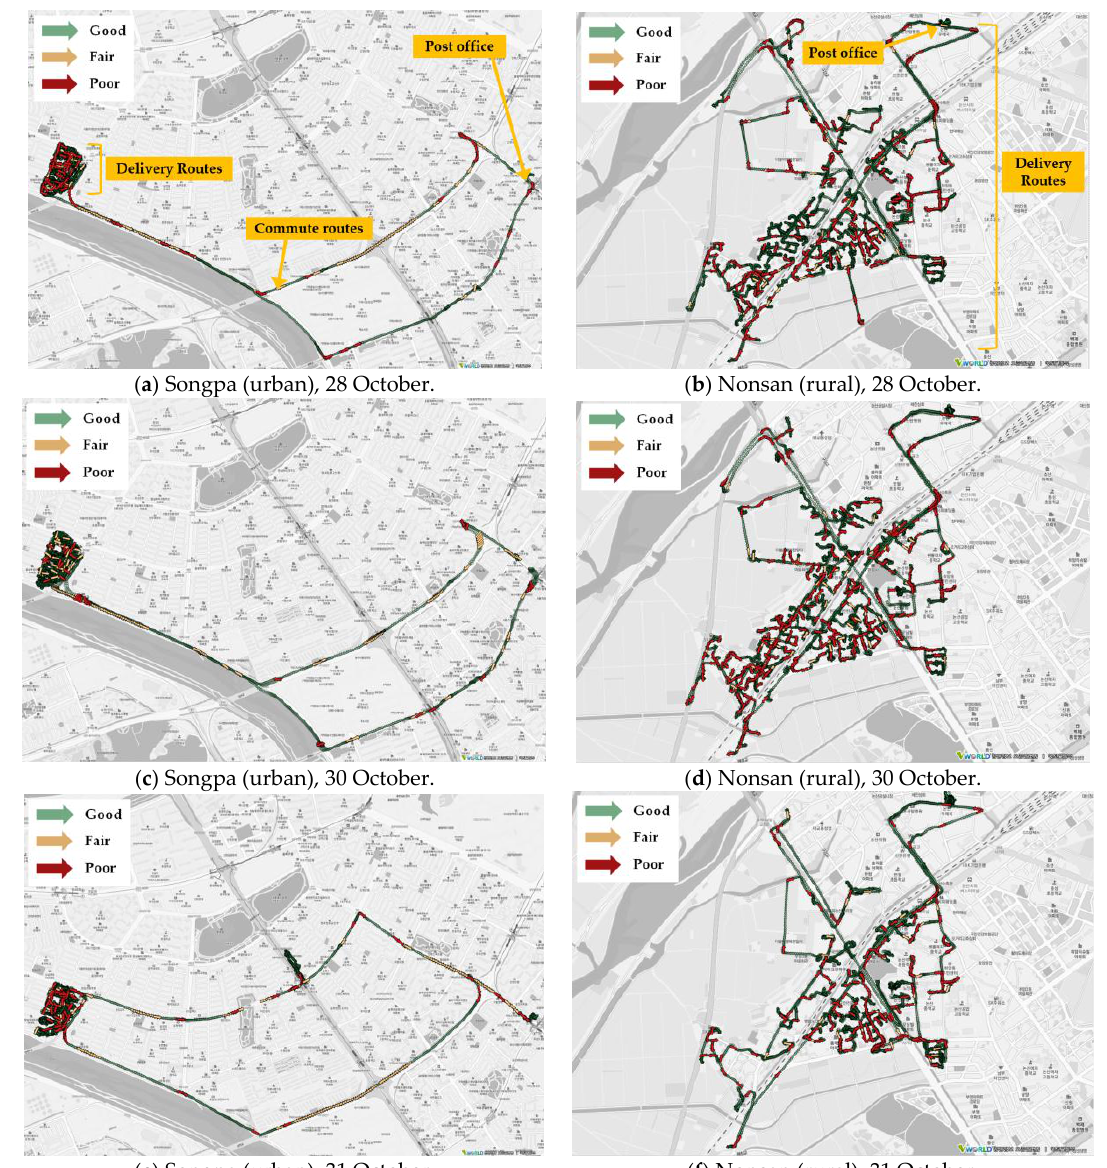
Figure 2. Distribution of a postal motorcyclist’s safety index plotted on a work route extracted from GPS data gathered by a system installed on the postman’s personal digital assistant (PDA) in Songpa (urban) and Nonsan (rural): green for “Good”, yellow for “Fair”, red for “Poor” for the safety performance.